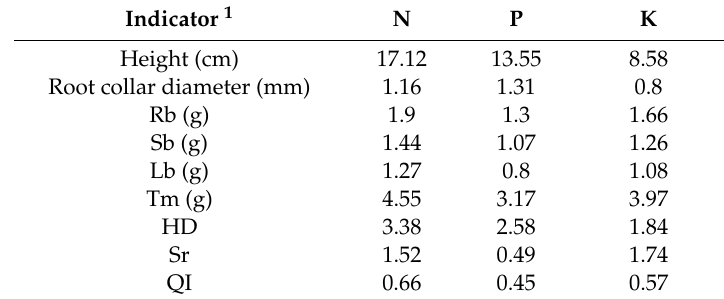
Table 4. Range analysis of Phoebe bournei seedlings attributes measured at the end of the trial in response to the 14 fertilization